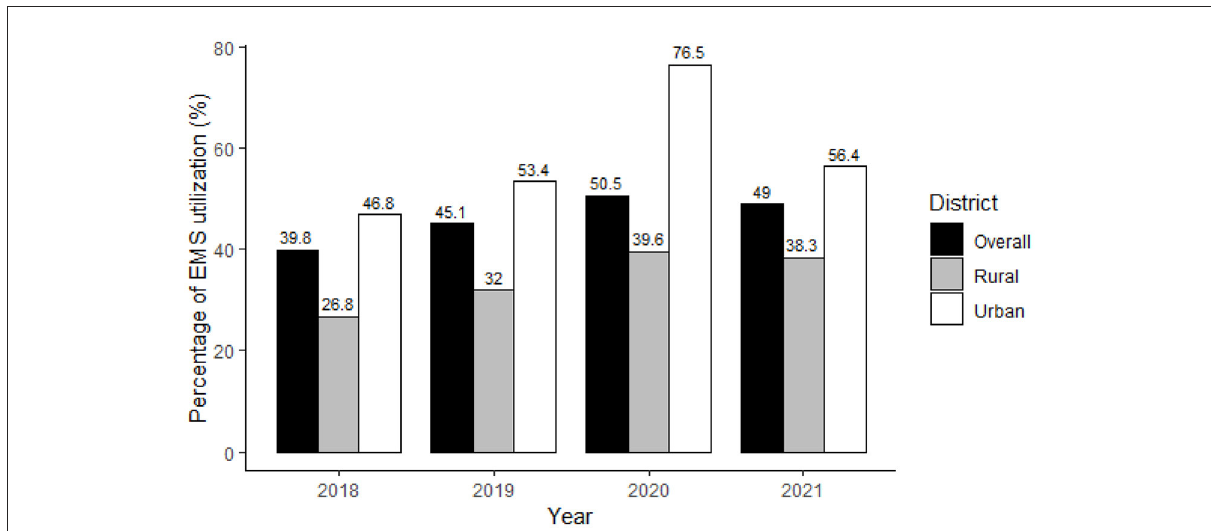
FIGURE2 Percentage of EMS utilization in AIS patients in Beijing,